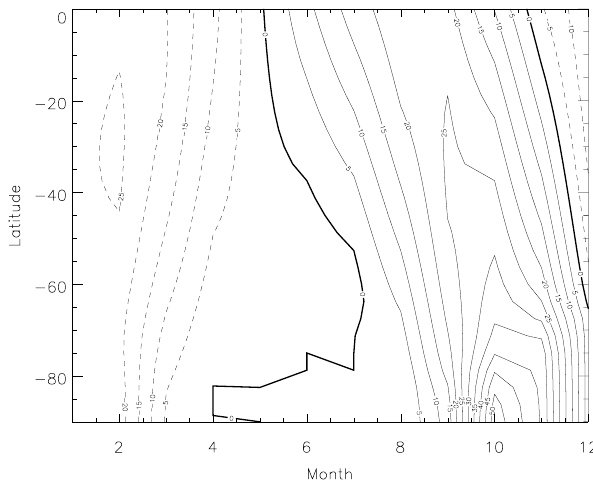
Fig. 1. The difference in zonal, seasonal mean insolation for the Mid-Holocene relative to the pre-industrial control (Wm − 2 ), aver- aged over the five models used in the main analysis. Positive (neg- ative) values are indicated by the solid (dashed) lines. The zero line is the thick black